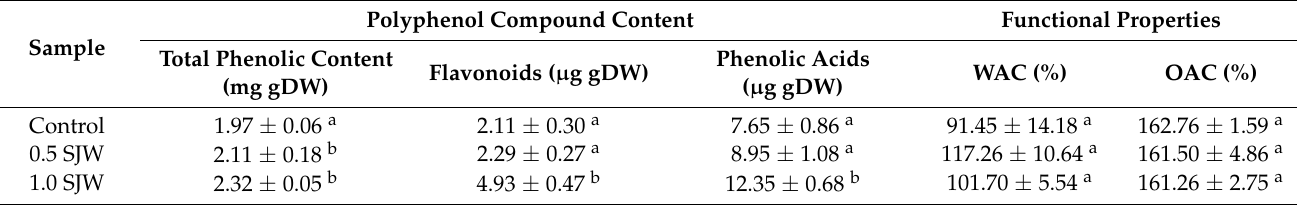
Table 1. Phenolic compound content and functional properties of extracts obtained from cookies.